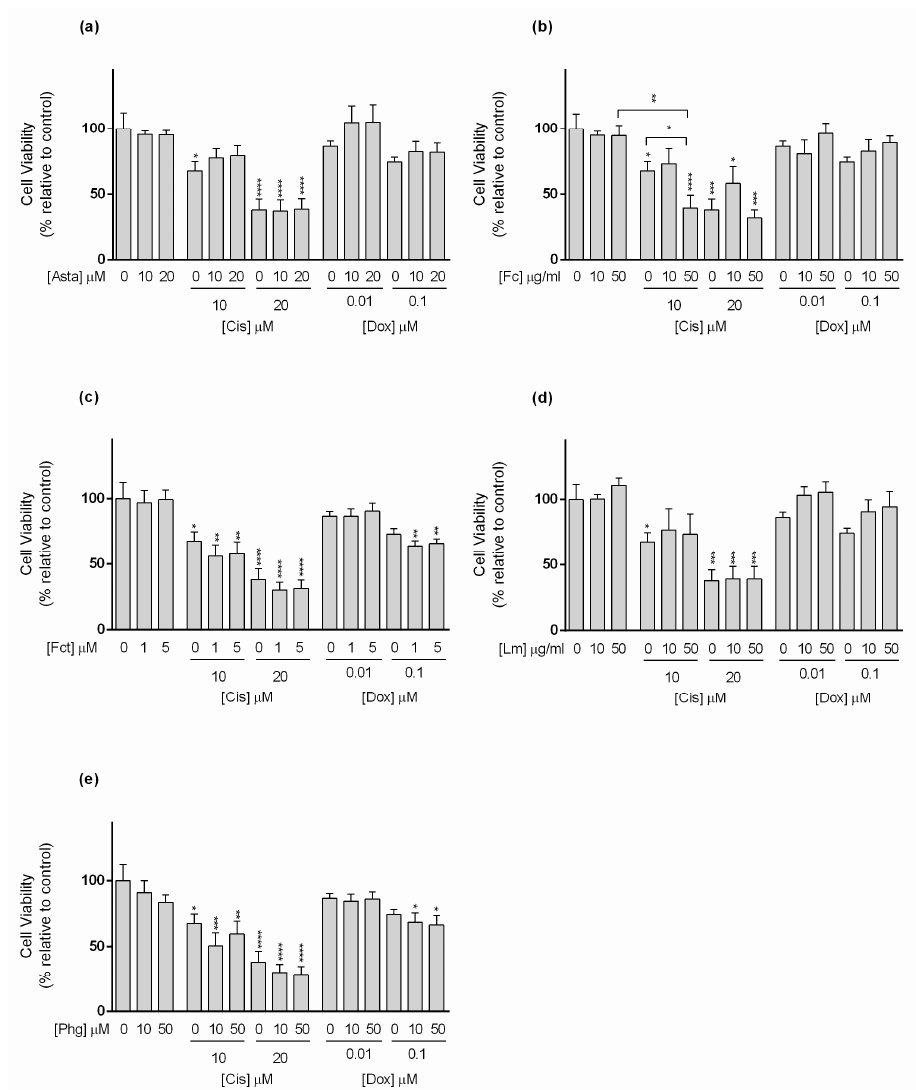
Figure 5. Cytotoxic effects of the combination of ( a ) Astaxanthin (Asta); ( b ) Fucoidan (Fc); ( c ) Fucosterol (Fct); ( d ) Laminarin (Lm); ( e ) Phloroglucinol (Phg) with the reference drugs cisplatin (Cis) and doxorubicin (Dox) assessed by the MTT assay after 72 h of exposure in SKBR3 cell line cultured in monolayer. Control corresponds to cells incubated with medium containing 0.1% DMSO. The percentages of cell viability are relative to the control and presented as mean + standard deviation of six independent experiments (each in triplicate). Square brackets indicate t tests with Sequential Bonferroni corrections. (* p < 0.05, ** p < 0.01; *** p < 0.001, **** p < 0.0001). With reference to the TNBC cell line MDA-MB-231 (Figure 6), Cis (10 and 20 μ M) alone did not present significant differences in cell viability in relation to the control. Con- versely, when in the following combinations Cis 20 μ M plus Fc (10 and 50 μ g/mL), Lm (10